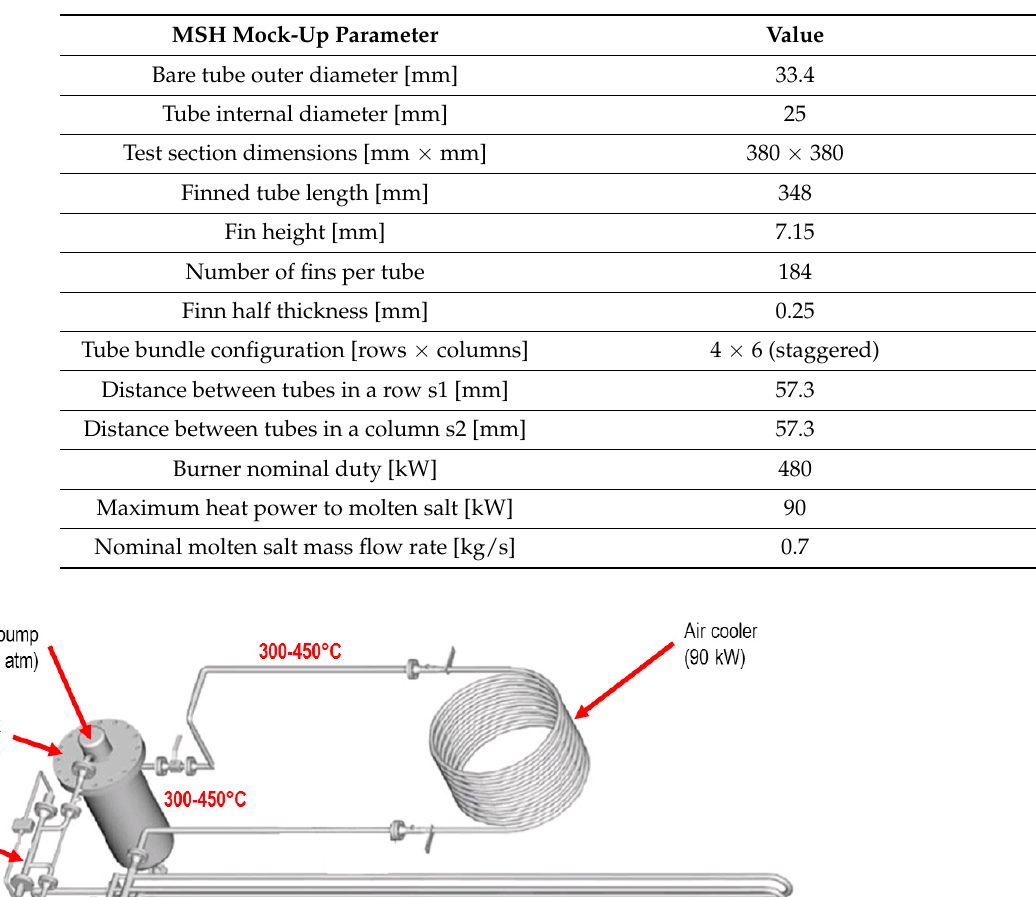
Table 1. Main features of the MSH mock-up.